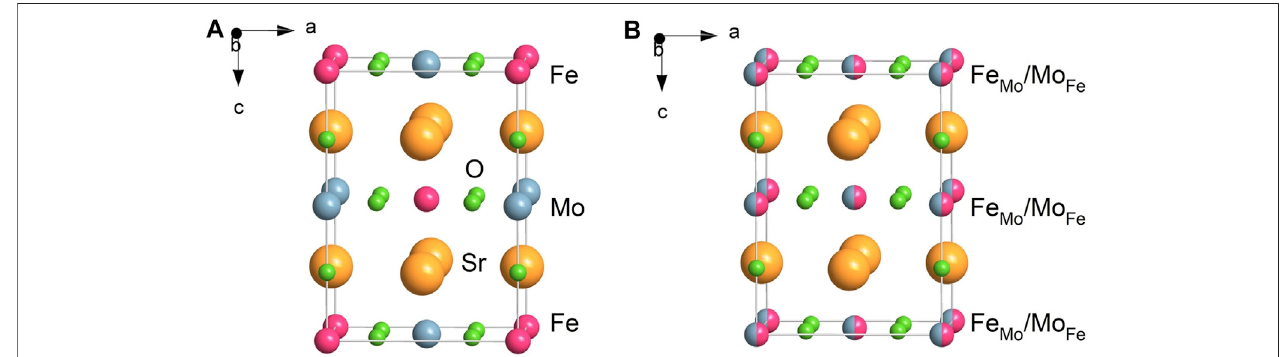
FIGURE1| Schematicpresentationofthetetragonalstructureof (A) the fullyordered and (B) the fullyanti-sitedisordered doubleperovskiteSr 2 FeMoO 6 .Inthefully orderedSr 2 FeMoO 6 ,theFeandMocationsalternateregularlyalongthe c -axisofthetetragonalcrystallattice.Inthefullyanti-sitedisorderedSr 2 FeMoO 6 ,thecationsare randomly distributed over the sites of octahedral coordination provided by the double perovskite structure. The crystal chemical formula of the fully disordered Sr 2 FeMoO 6 , emphasizing the cation site occupancy at the atomic level, may be written as Sr 2 [Fe Fe ] 0.5 [Fe Mo ] 0.5 [Mo Mo ] 0.5 [Mo Fe ] 0.5 O 6 , where [Fe Fe ], [Mo Mo ] and